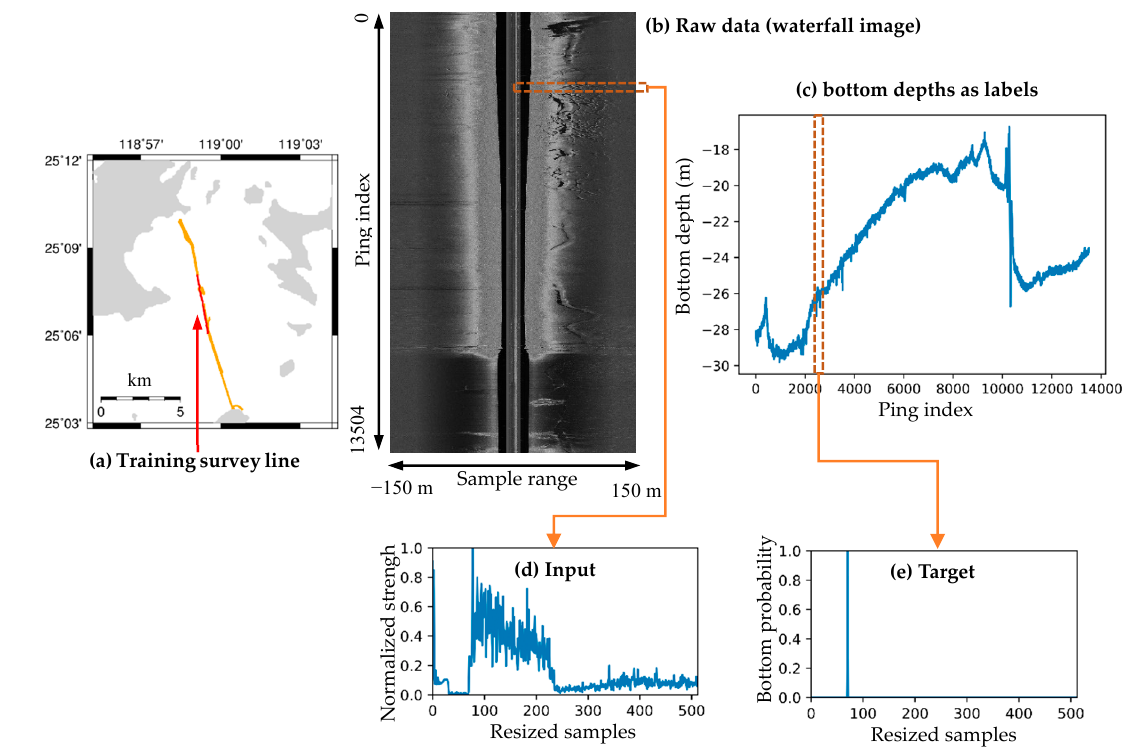
Figure 8 . Sampling for input and target data from the measured side-scan data. ( a ) is the selected survey line for the training; ( b ) is the waterfall image constructed using the backscatter strength data; ( c ) shows the known sea bottom result of the survey line; ( d ) is the input sequence from a port-side ping data; and ( e ) shows the corresponding target sequence that represents the bottom probabilities.